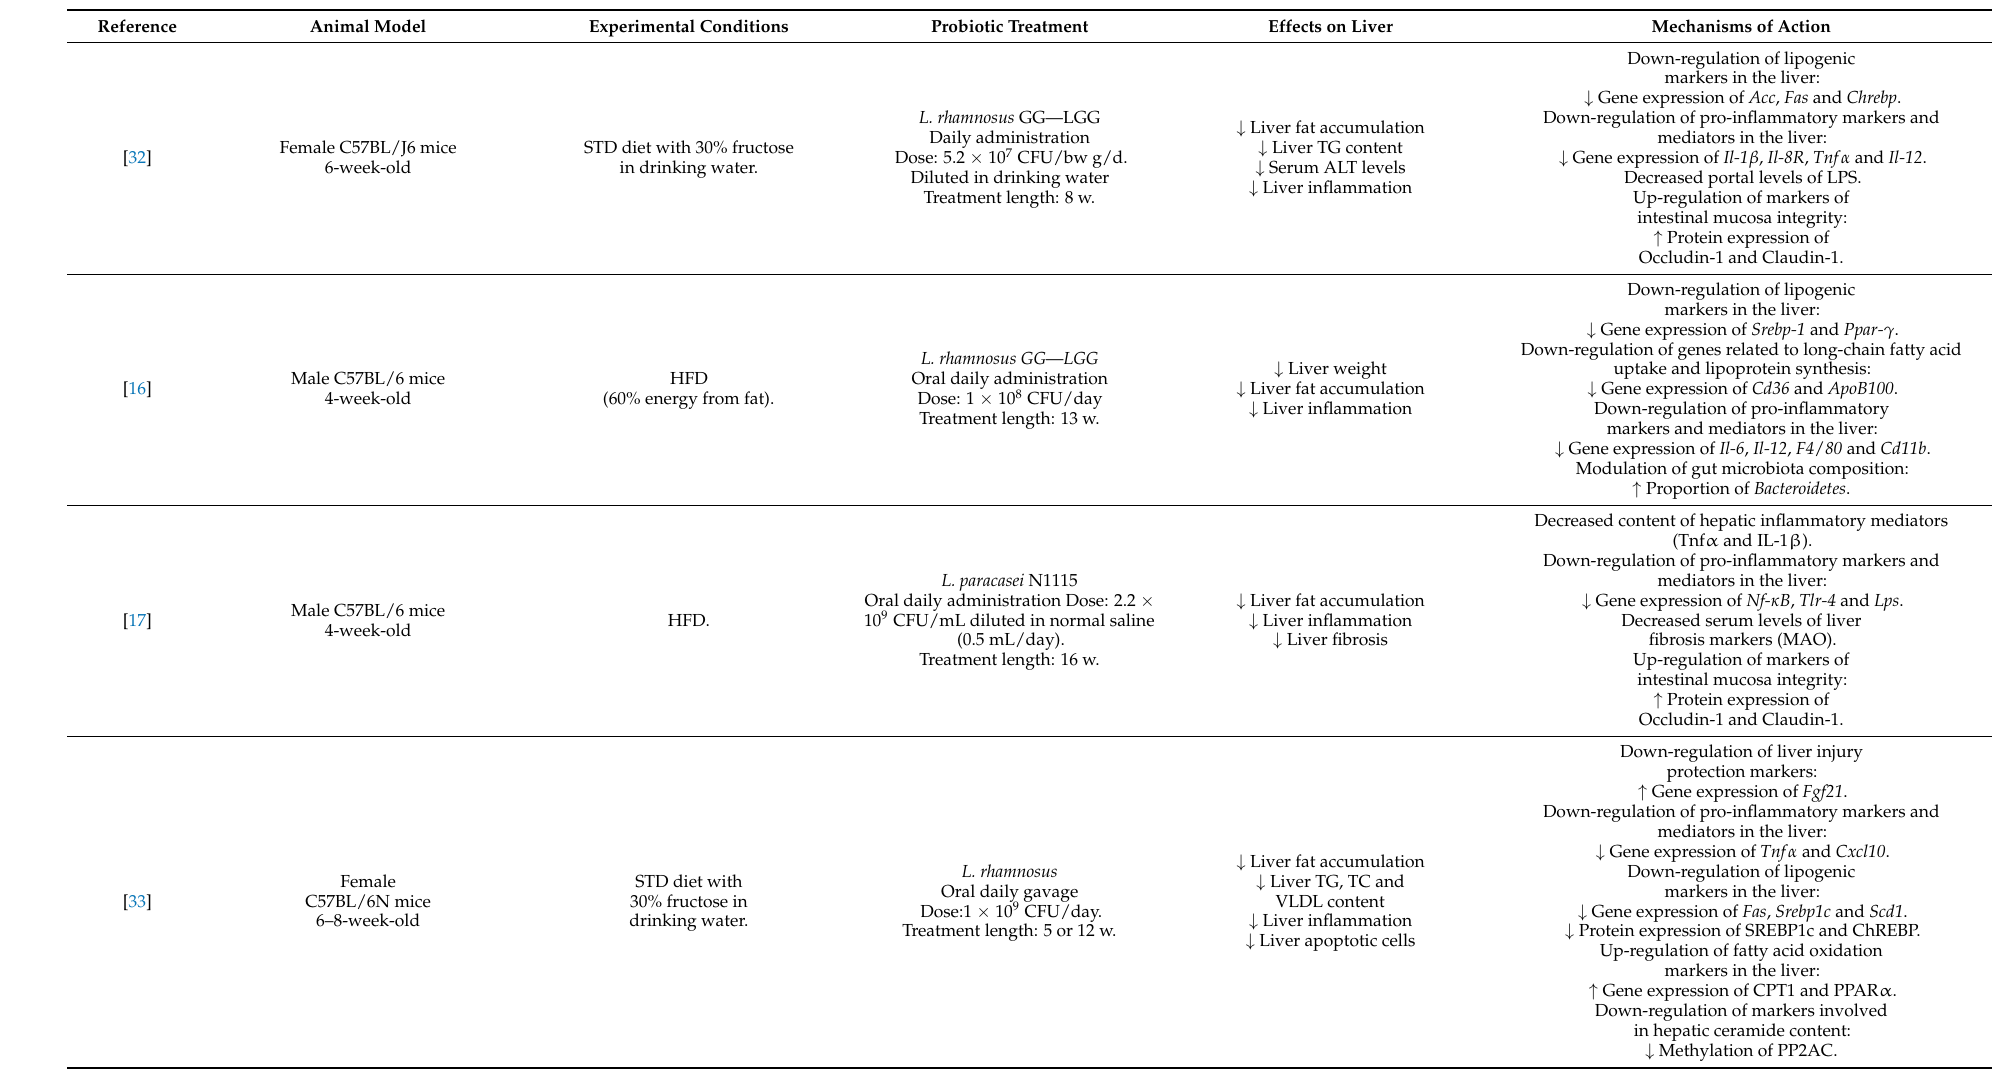
Table 1. Preclinical studies (rodent models) addressing the effects of different single-strain probiotics on diet-induced